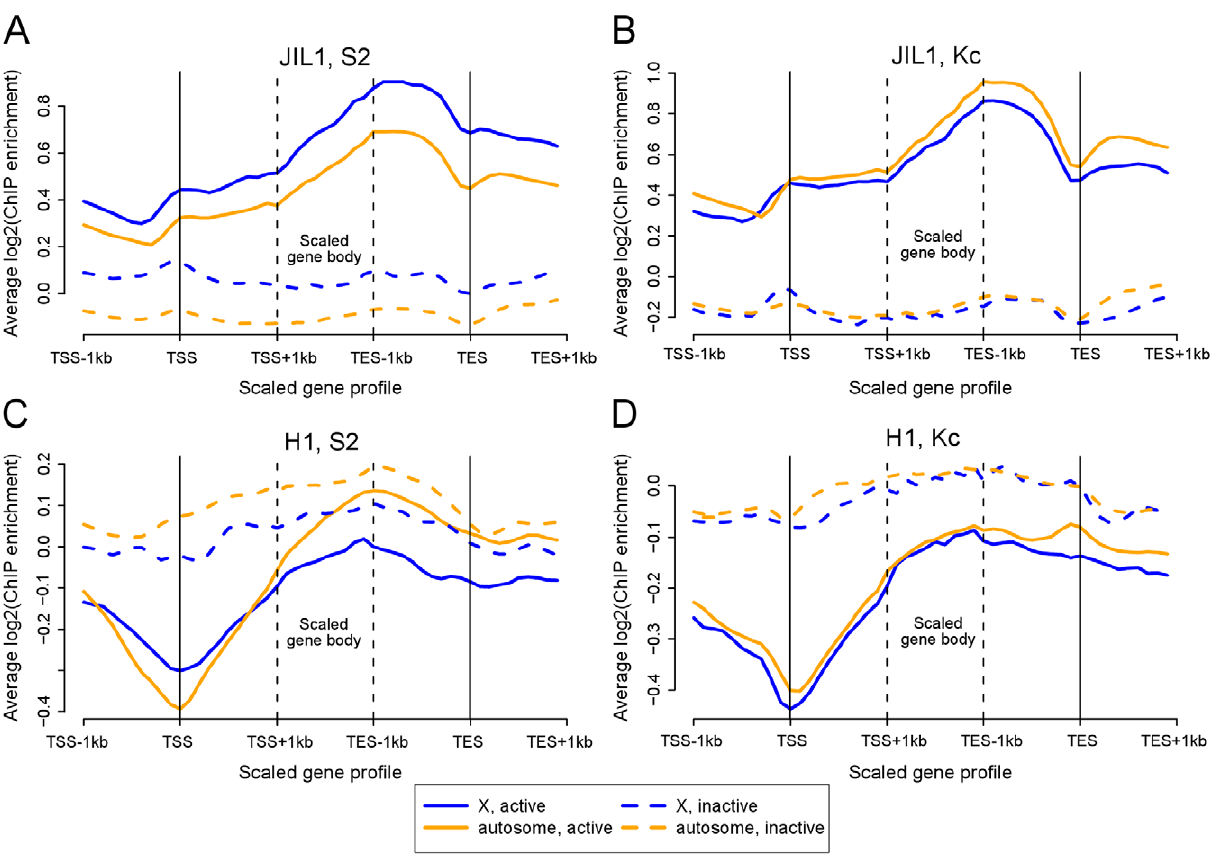
Figure 5. The bodies of active X-linked genes are enriched for JIL-1 kinase and depleted for histone H1 in S2 but not Kc cell lines. Each panel shows the average scaled ChIP enrichment profile (meta-gene profile) of active and inactive genes located on X chromosome and autosomes. (A) JIL-1 in S2 cells, (B) JIL-1 in Kc cells, (C) H1 in S2 cells, and (D) H1 in Kc cells. Notably, JIL-1 is enriched along the gene bodies of X-linked genes in males, while histone H1 is depleted. See also Figure